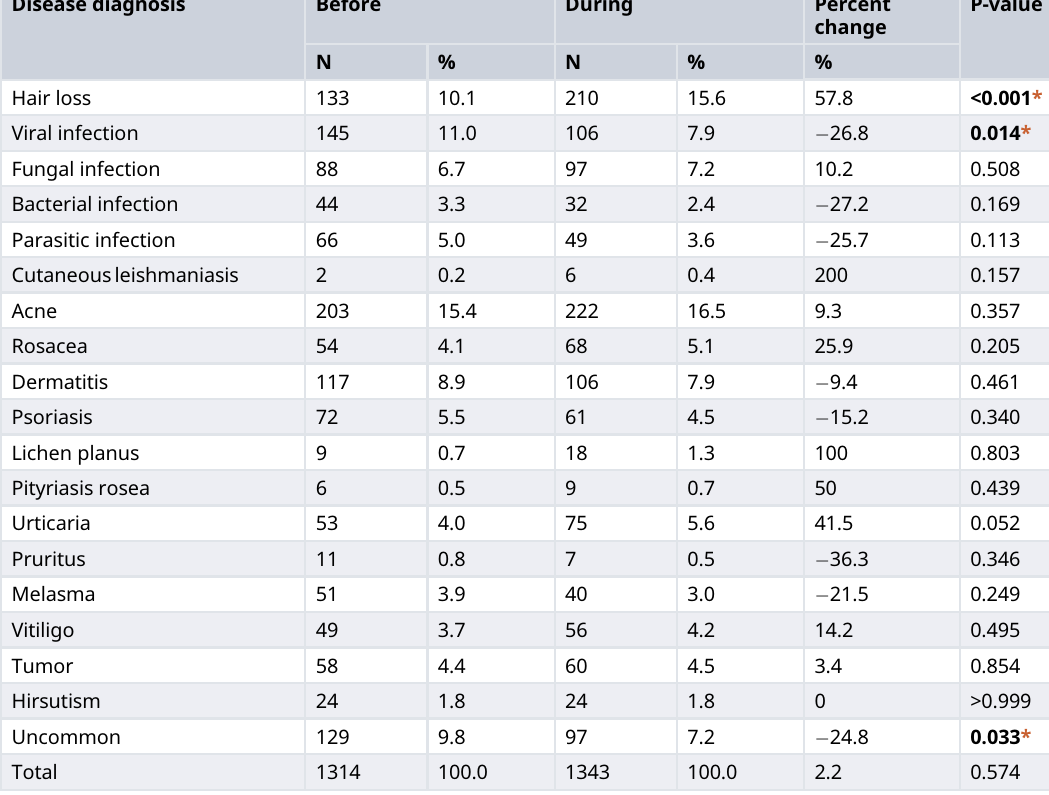
Table 1. The types of dermatological diseases before and during the coronavirus disease 2019 (COVID-19) pandemic. Disease diagnosis Before During Percent